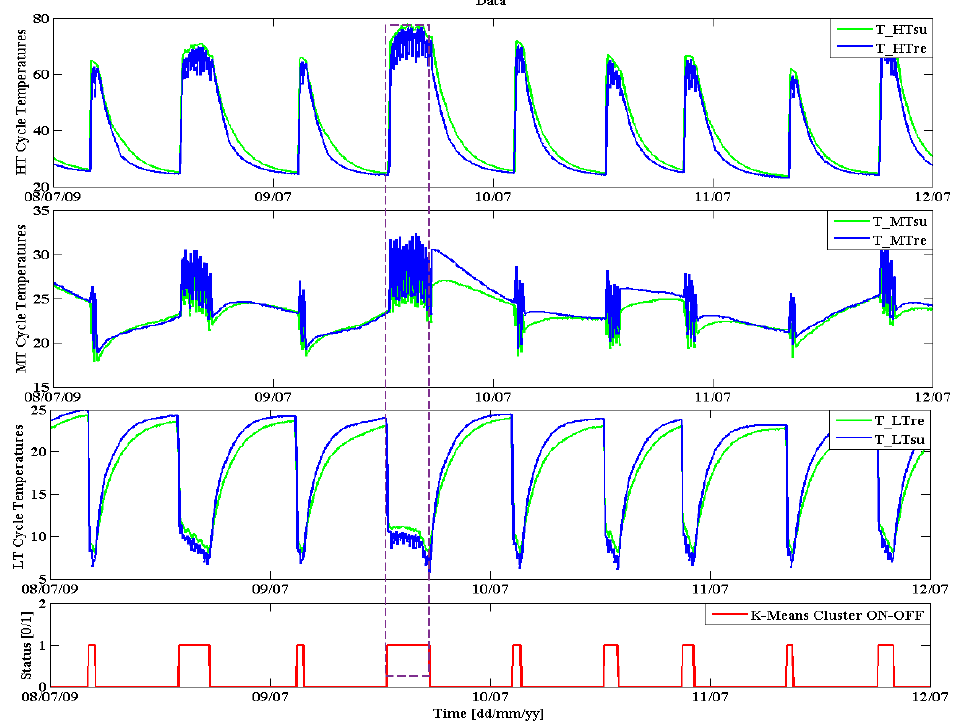
Figure 7. Automatically detected On/Off state time series using k ‐ means clustering algorithm. Table 3. K ‐ Means On/Off accuracy.